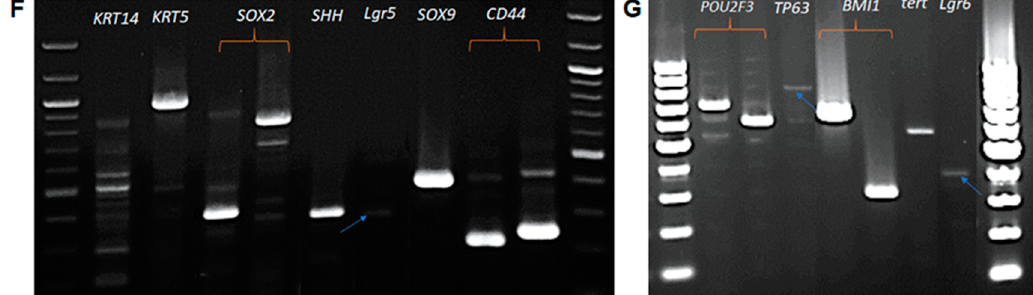
Figure 3. RT-PCR study of mRNA expression of taste cell markers including: ( A ) α -gustducin ( GNAT3 ), TRPM5 , Tas1R1, Tas1R2, PLC- β 2 and PKD2L1 ; ( B ) Tas2R3 and Snap25 ; ( C ) ENTPD2 and T1R3 ; and ( D ) voltage-gated sodium channels. ( E ) mRNA expression of bitter taste receptors; all the gene-specific primers yielded a single PCR product with a correct amplicon size except the second primer set of T2R7 ; and ( F , G ) cell fate and differentiation